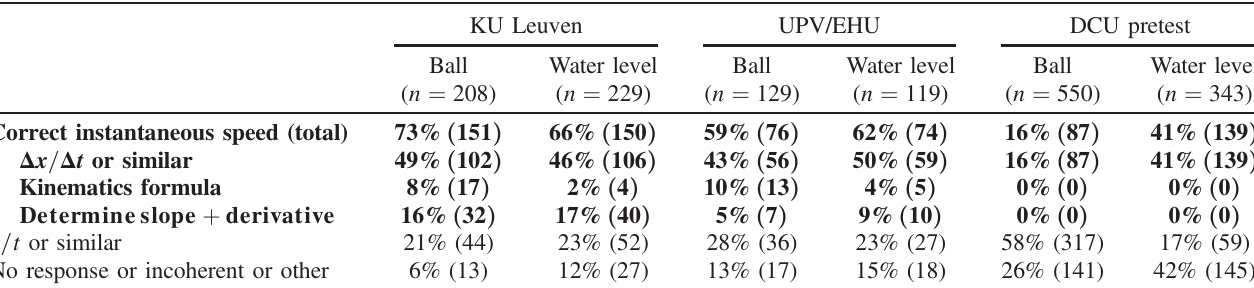
TABLE II. Categorization and prevalences of approaches to determining the speed at a particular instant. Correct responses are printed in